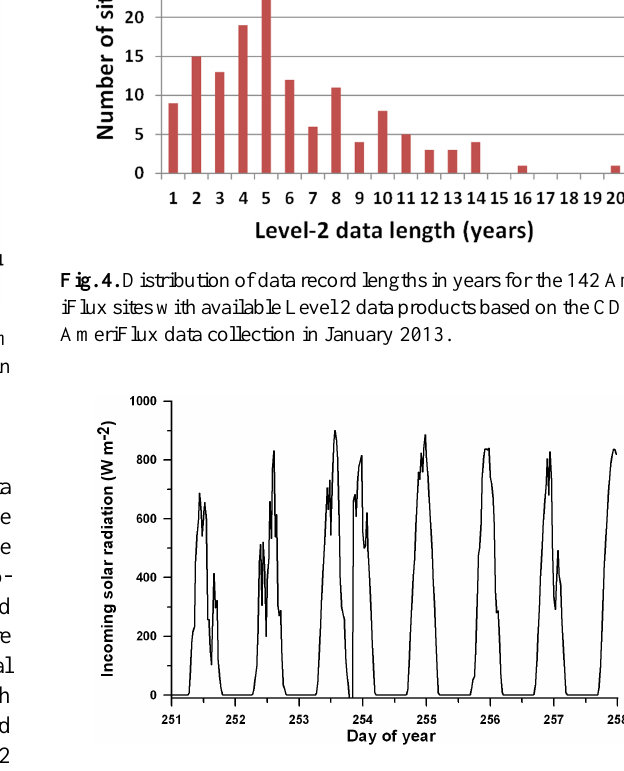
Fig. 5. CDIAC uses graphics and visualization tools to review time series for all measured AmeriFlux variables, assess data quality, and identify possible errors. This plot shows an erroneous time shift be- ginning on day 254 for incoming solar